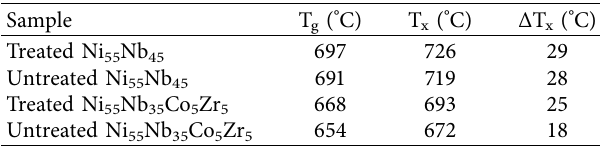
Table 1: thermal parameters of samples.